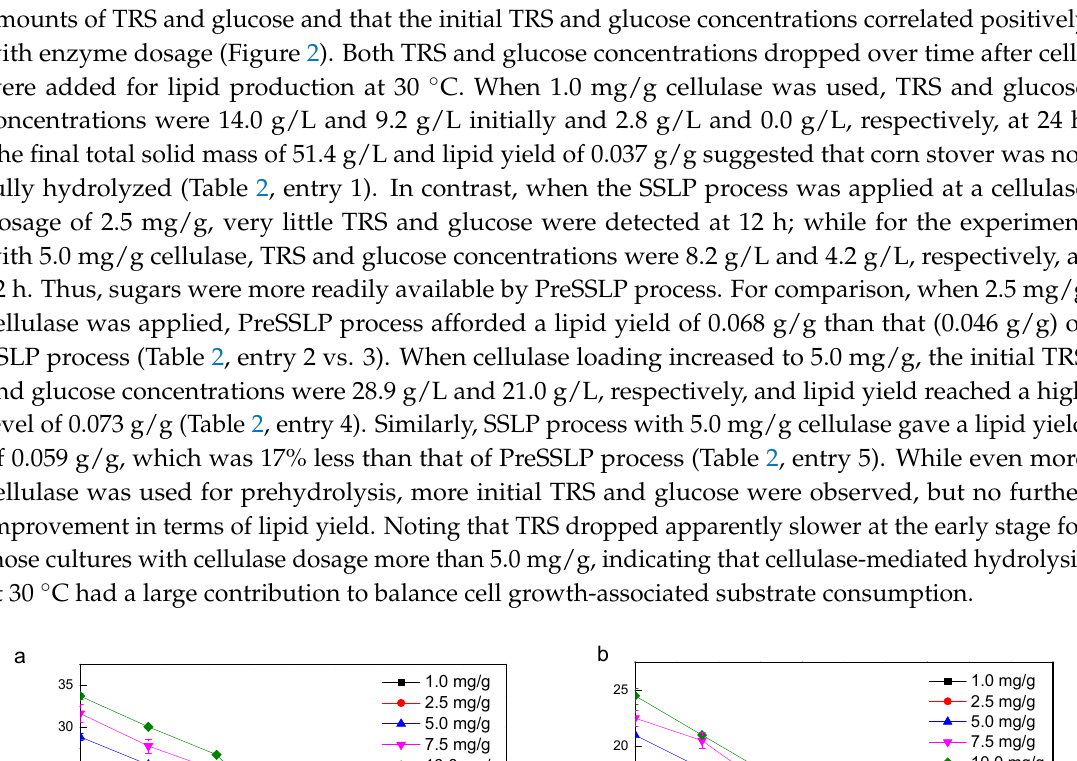
Table 2. The results of lipid production at 30 °C with various amounts of cellulase.